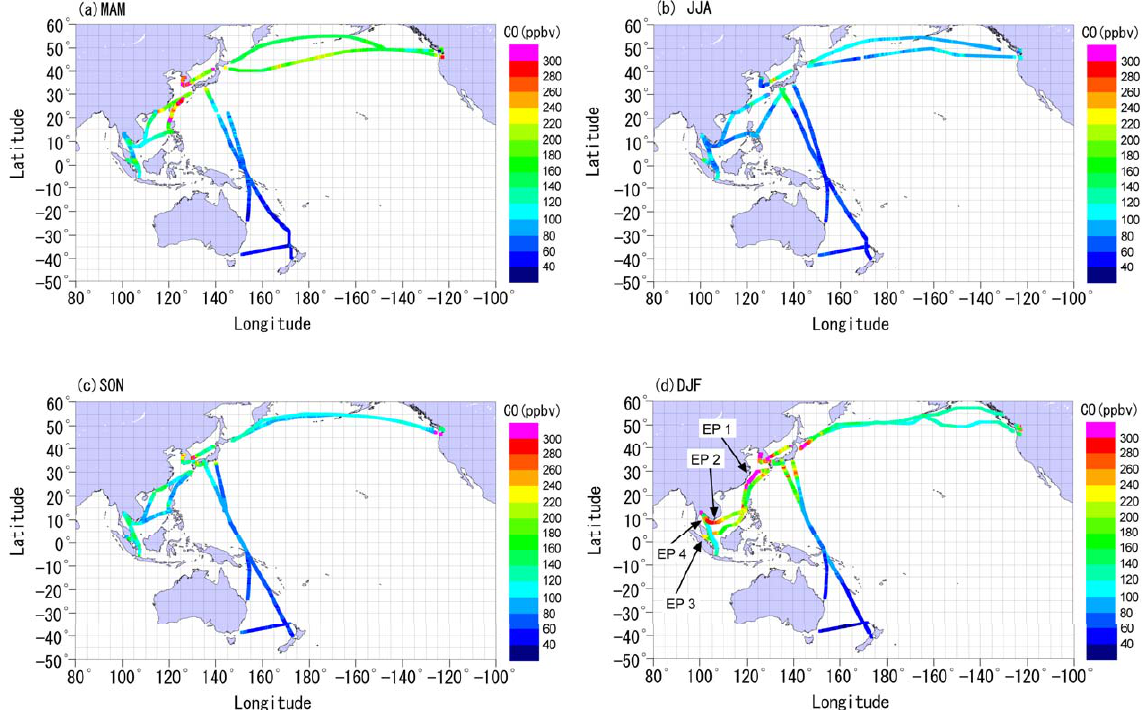
Figure 9. Distribution of CO mixing ratios observed by three ships from March 2008 to February 2009: (a) March, April, and May (MAM), (b) June, July, and August (JJA), (c) September, October, and November (SON), (d) December, January, and February (DJF). Episode numbers (EP1, 2, 3, and 4) in Figure 9d correspond to those in Figure 6.